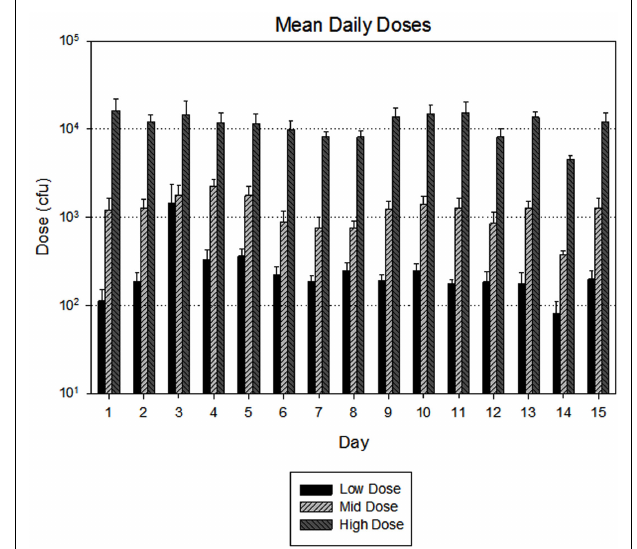
FIGURE 3 | Mean 15day low-dose inhalation challenge data. The figure illustrates the mean inhaled dose (bars) with standard deviation compared to the target dose (dashed horizontal log increment lines).The low-dose target was 10 2 , the mid-dose target was 10 3 , and the high-dose target was 10 4